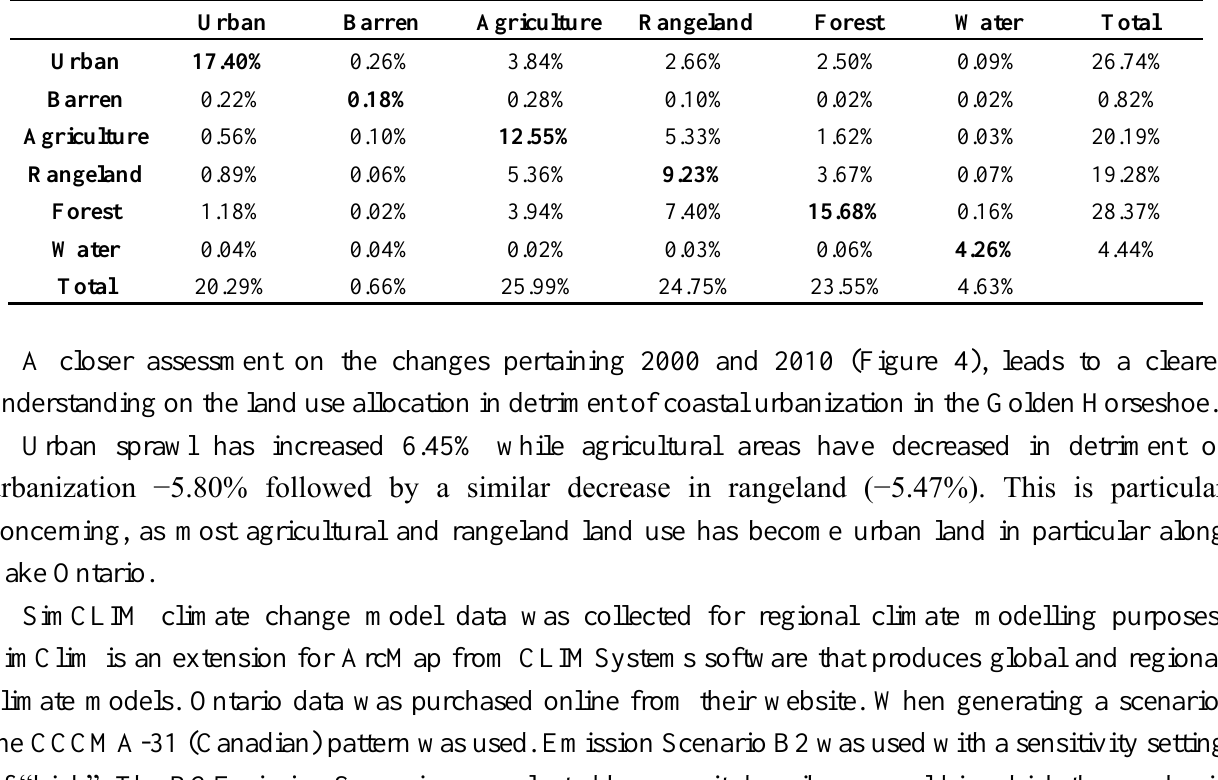
Table 1. Land Use allocation between 2000 (columns) 2010